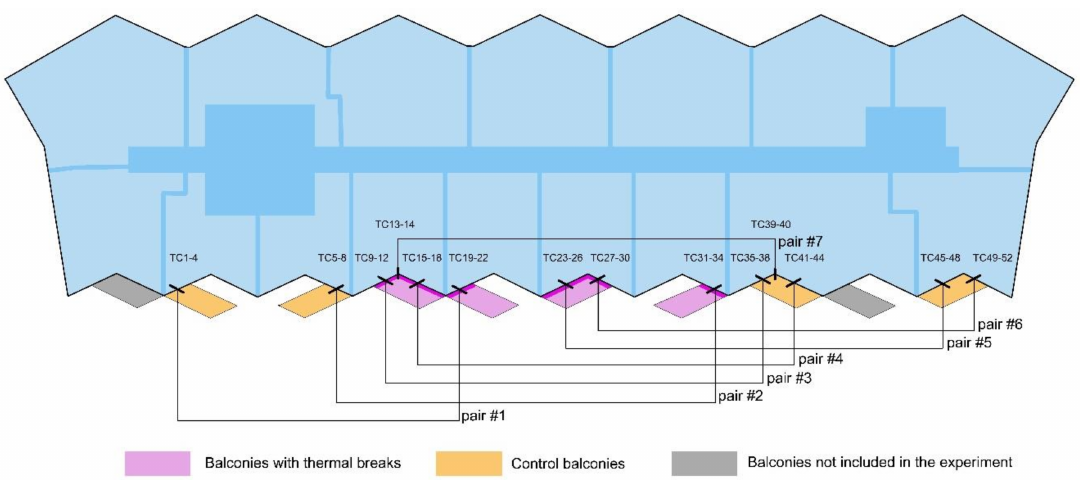
Figure 3. Floor plan showing the eight studied balconies on the 13th floor: Four balconies with thermal breaks and four conventional balconies without thermal breaks. Each balcony comparison pair was chosen based on similar geometries. Comparison balcony pairs are labeled pair #1-7. TC = thermocouple.